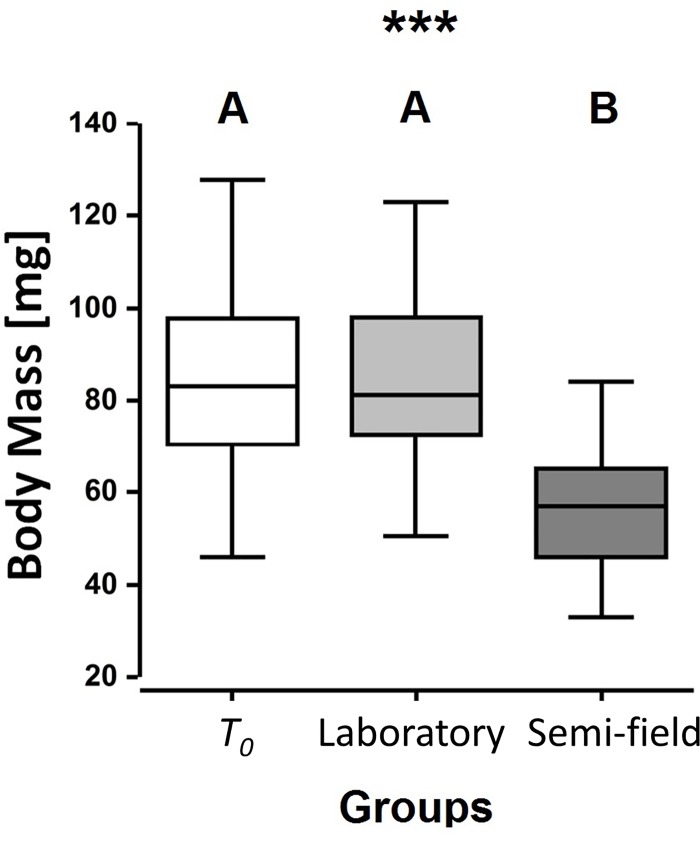
Body mass of Osmia cornuta males: Immediately post
emergence (T0 (N = 72)), after four days
under laboratory conditions (Laboratory (N = 36)) and after four days
under semi-field conditions (Semi-field (N = 36)).Significant differences among groups are indicated by different letters
(A, B), whereby *** represents p < 0.001.